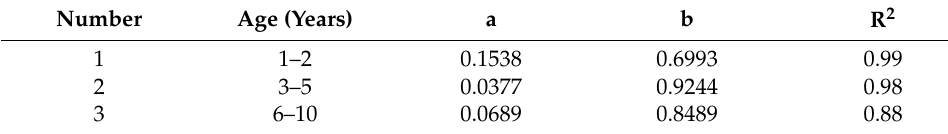
Table 2. Parameters used in tree-level allometric